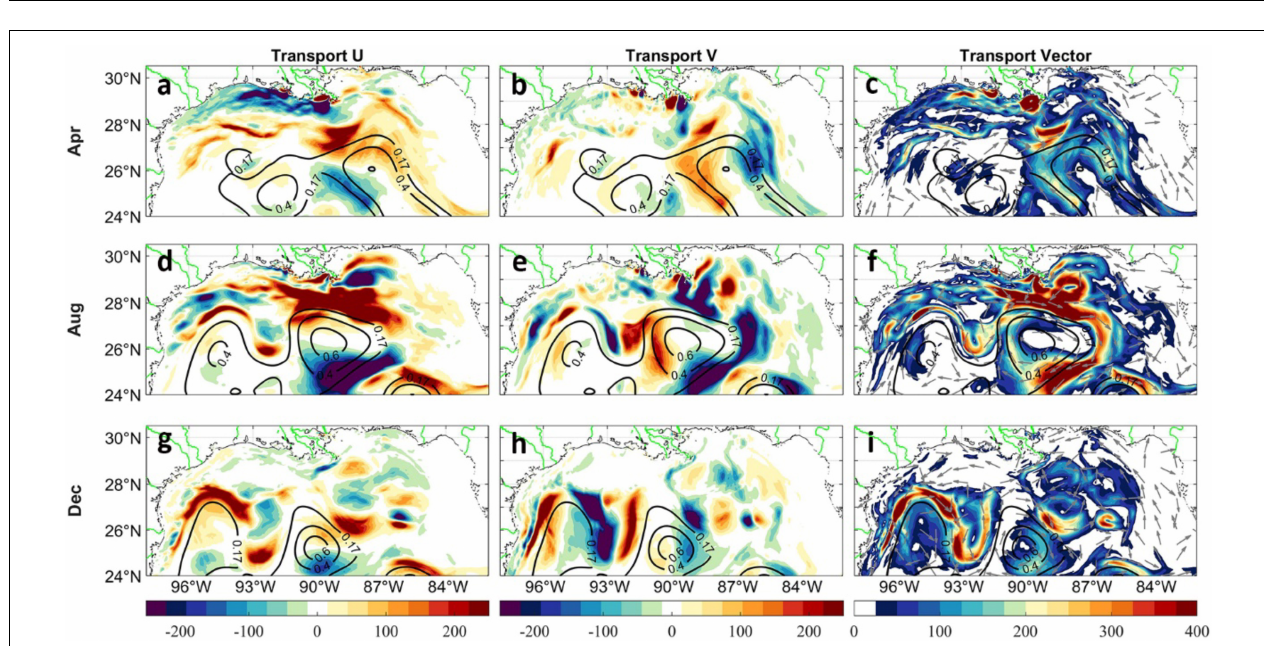
FIGURE 7 | Time series of frontal tendency (in log scale) over the 8 integration periods in all the members of the 5 ensembles averaged over the model domain for which the water column is deeper than 100 m.